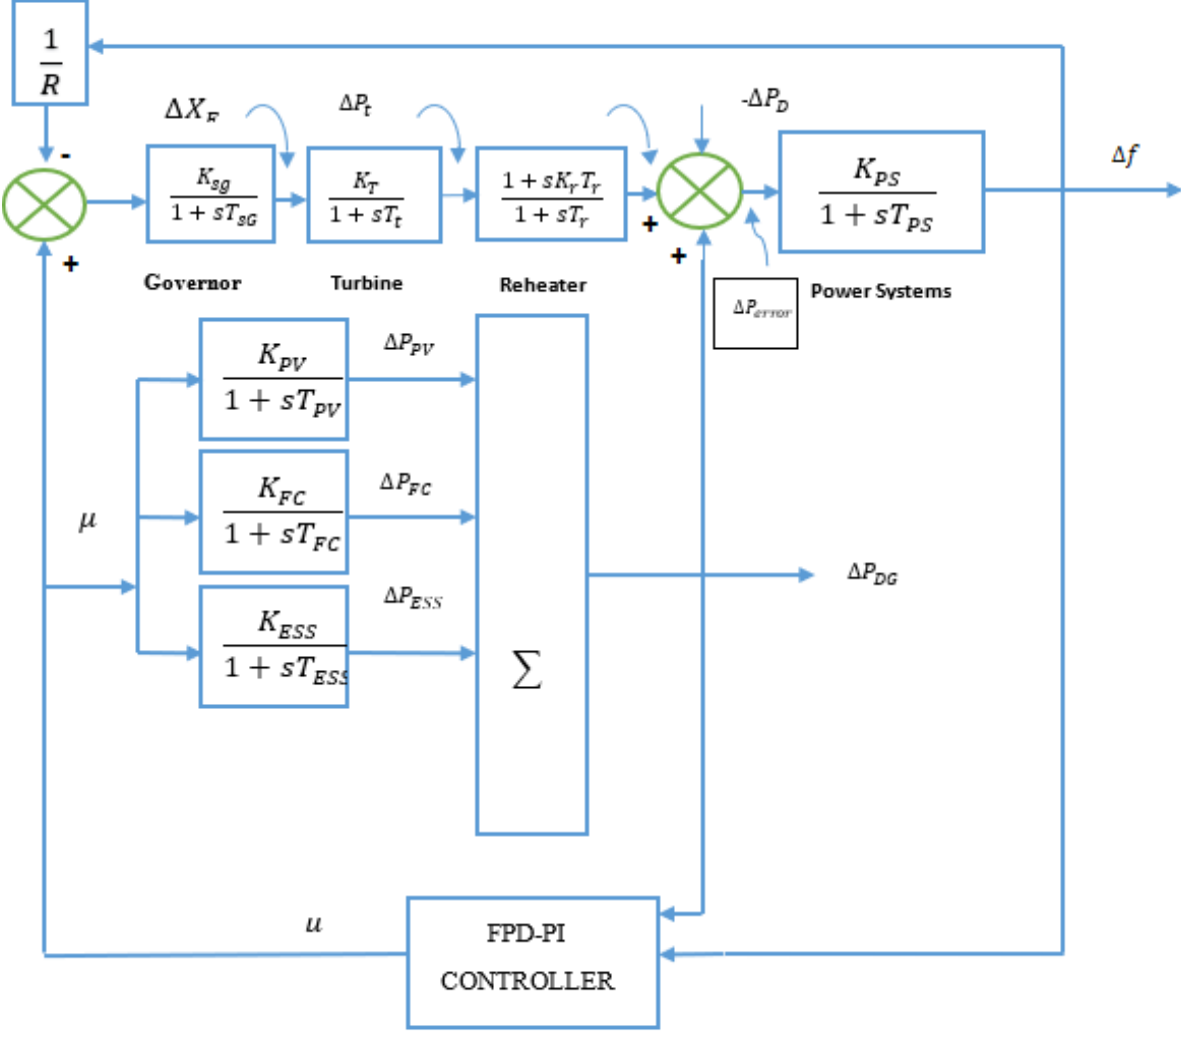
Figure 1. Transfer function model of the HPS understudy.